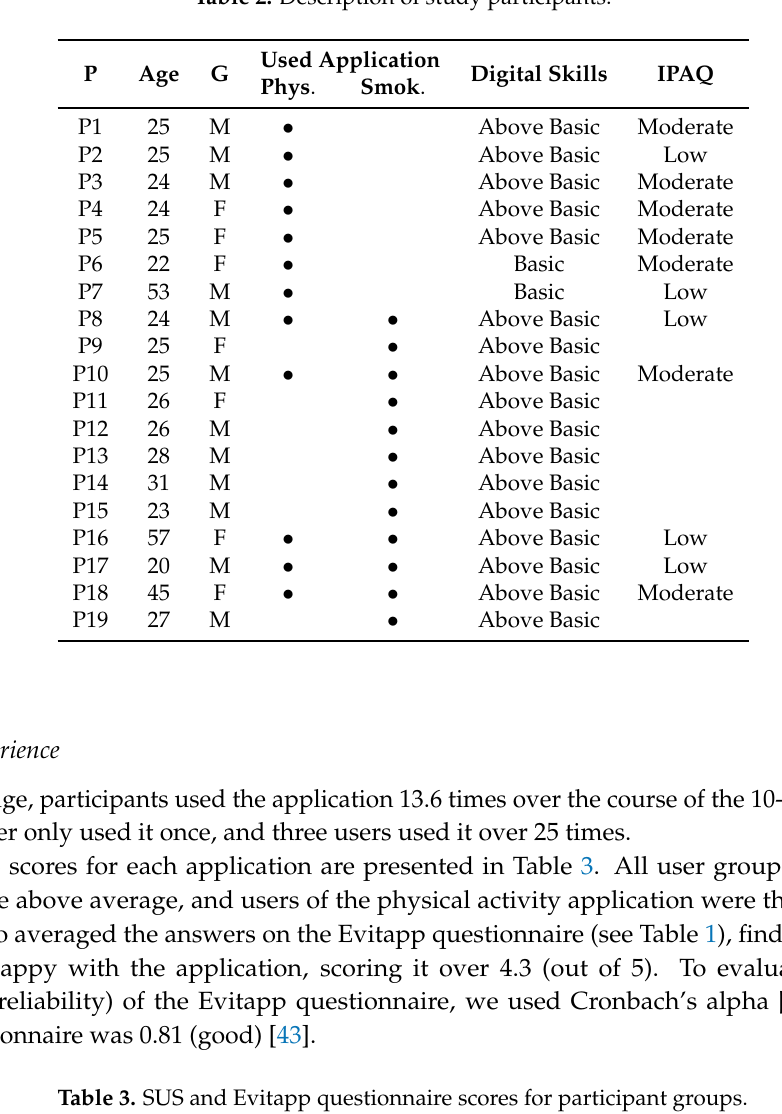
Table 2. Description of study participants.